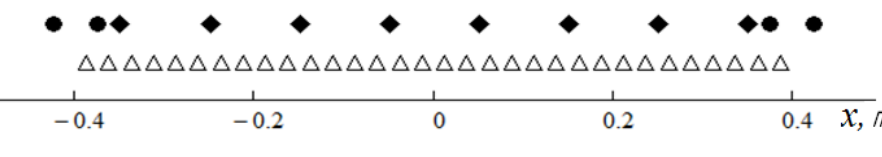
Fig. 1. The location of physical and virtual MIMO antenna system elements. Transmit elements are shown with dark circles, receive elements is shown with dark rhombs, virtual receive / transmit elements is shown with light